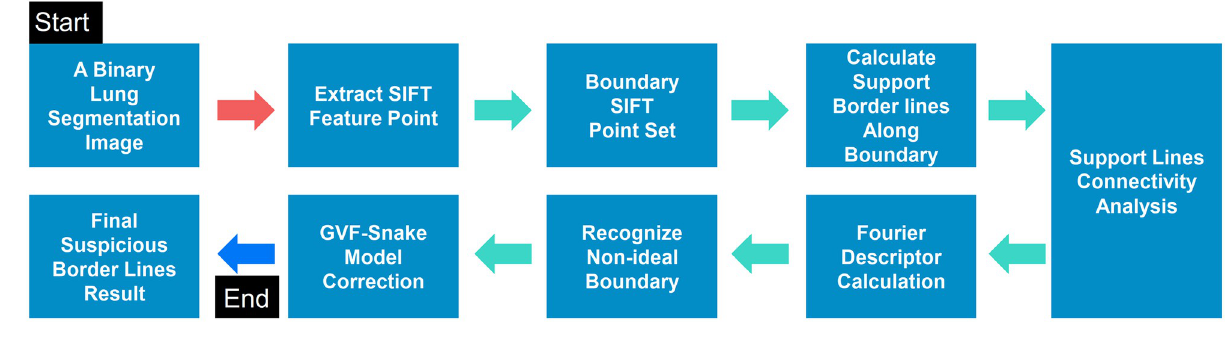
Fig 1. The main workflow of the proposed